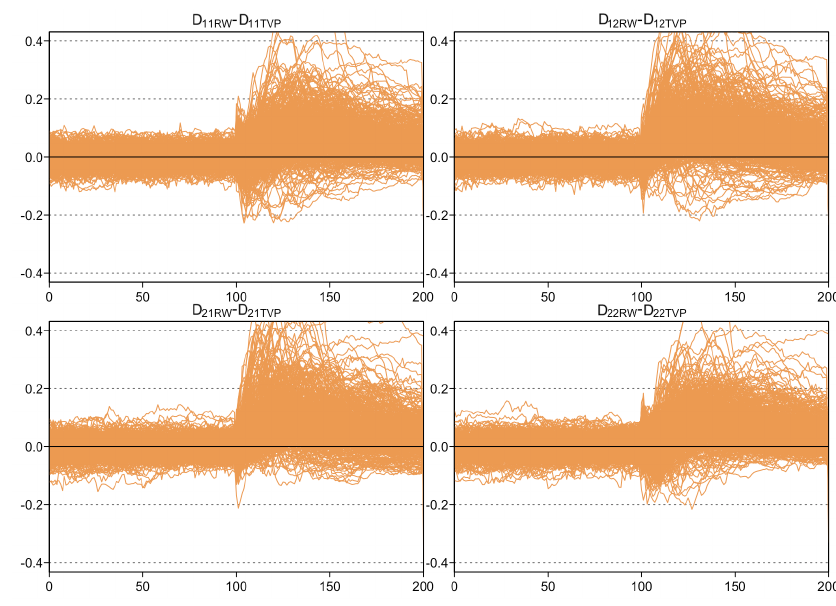
Figure 2. Monte Carlo simulation results with a structural break. Table 1. Monte Carlo simulation